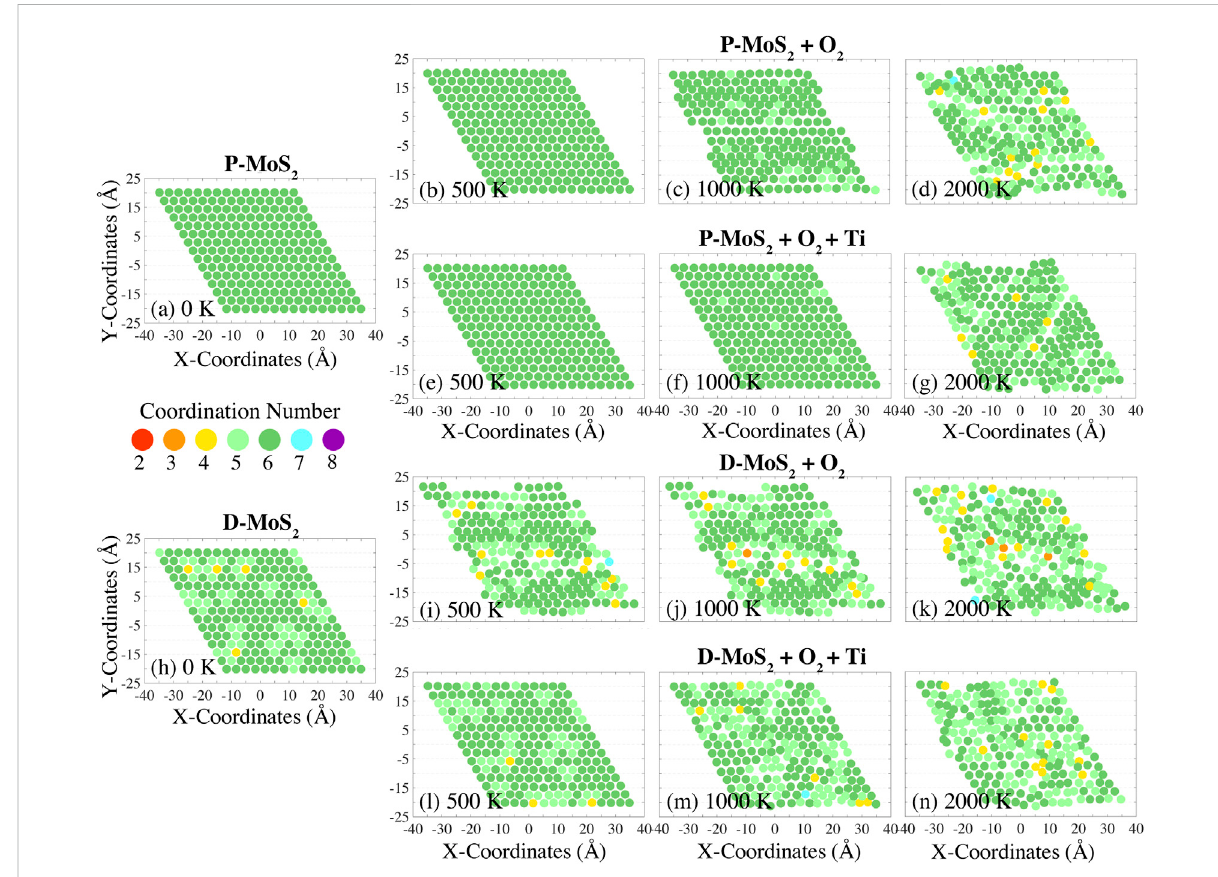
FIGURE 2 Variation of Mo atom coordination numbers during the temperature ramp with a rate of 10 K/ps, for pristine MoS 2 with O 2 (P-MoS 2 + O 2 ) at (B) 500 K, (C) 1,000K,and (D) 2,000K;pristineMoS 2 withO 2 andTiclusters(P-MoS 2 +O 2 +Ti)at (E) 500 K, (F) 1,000 K,and (G) 2,000K;defectiveMoS 2 with O 2 (D-MoS 2 + O 2 ) at (I) 500 K, (J) 1,000 K, and (K) 2,000 K; and defective MoS 2 with O 2 and Ti clusters (D-MoS 2 + O 2 + Ti) at (L) 500 K, (M) 1,000 K,and (N) 2,000 K.Thecoordinationnumbersfortheinitialcon fi gurations (at0 K)ofP-MoS 2 andD-MoS 2 arepresentedin (A) and (H) for